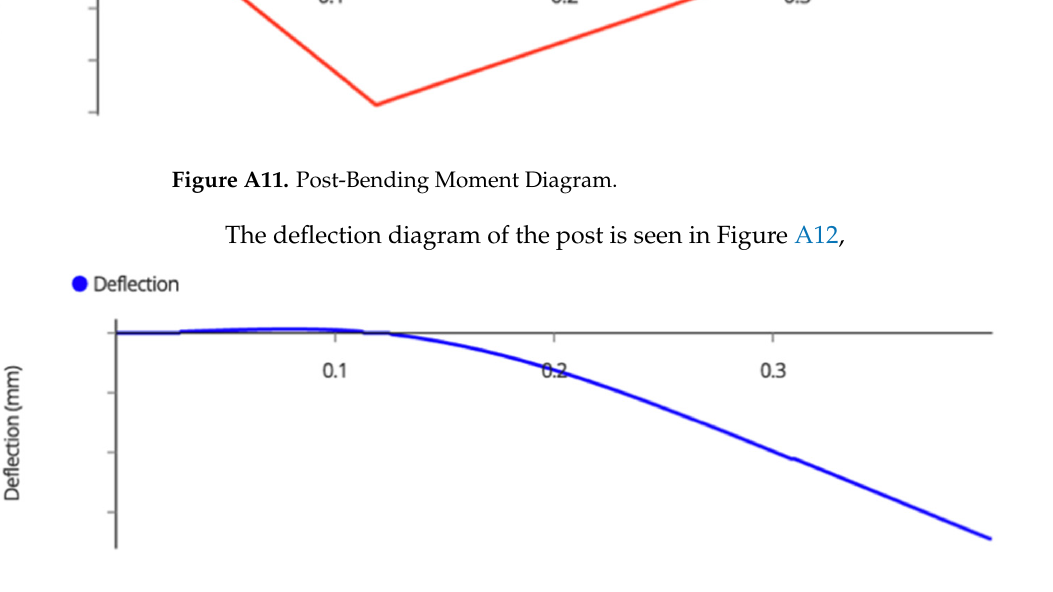
Figure A12. Post Deflection Diagram.